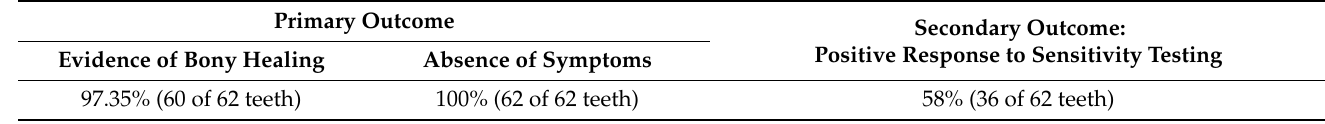
Table 7. Success rates obtained in adult permanent mature teeth performed by REP through random- ized clinical trials.